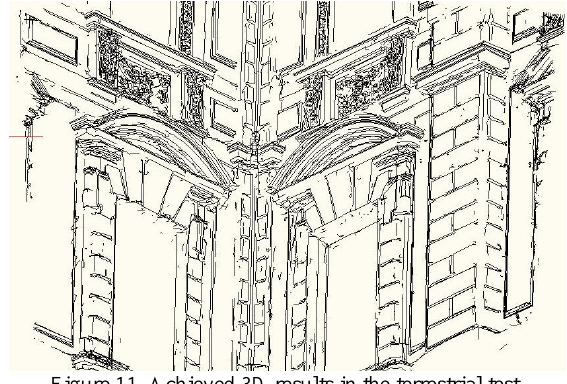
Figure 11. Achieved 3D results in the terrestrial test.